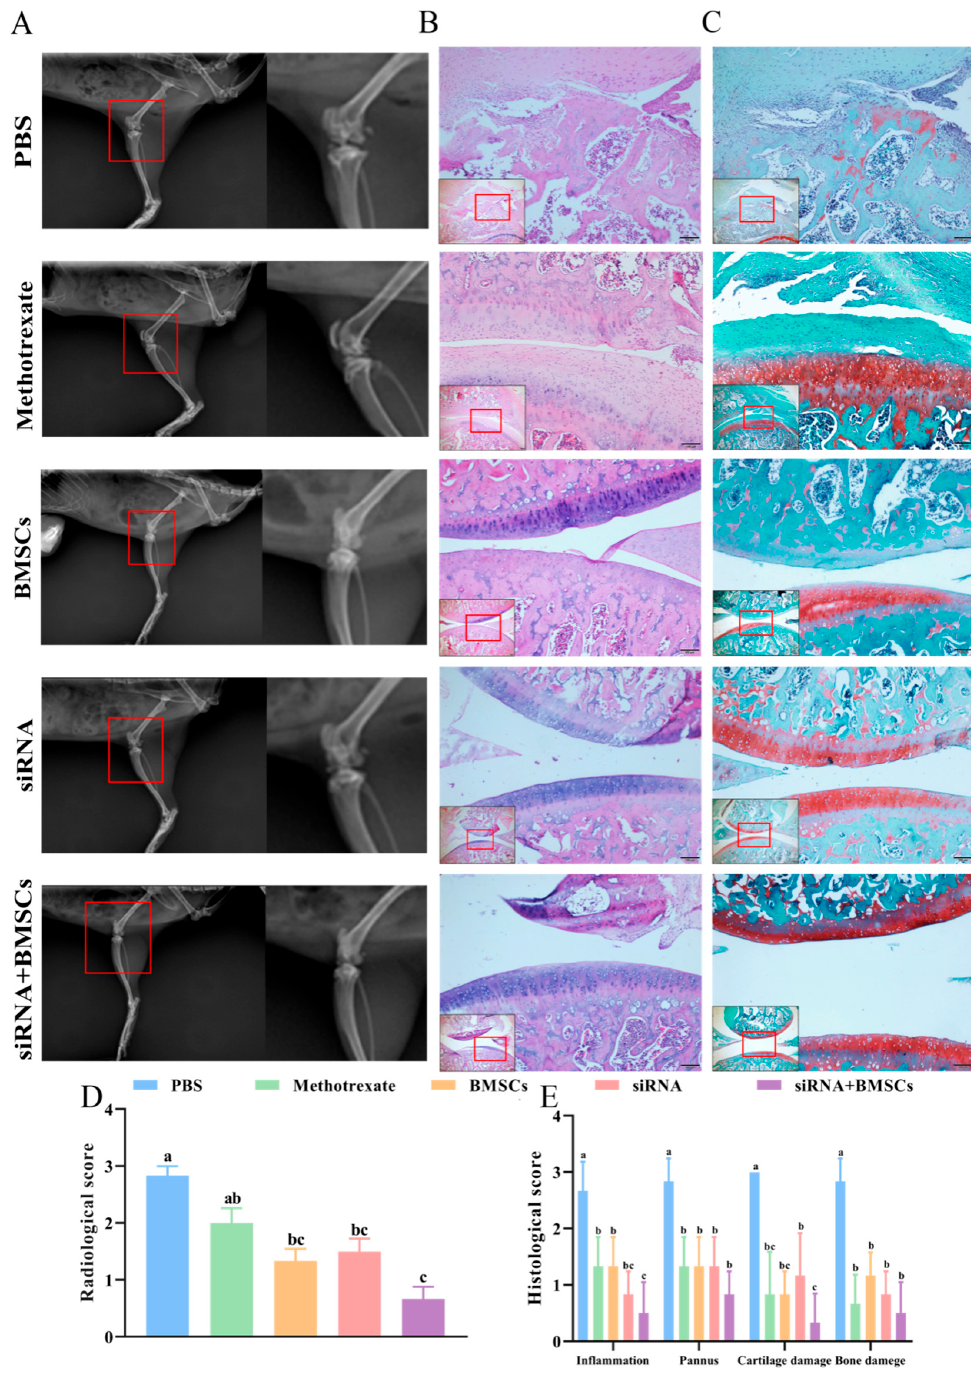
Figure 3. Histopathology of knee joint in CIA rats after 28 days treatment. ( A ), DR-X imaging of knee joint of CIA rats. ( B ), HE staining results of pathological slices of knee joint of CIA rats. (200 µ m, 100 µ m). ( C ), Safranin-O-green staining results of pathological slices of knee joint of CIA rats (200 µ m, 100 µ m). ( D , E ), The radiological and histological scores were evaluated and analyzed, respectively. Values are presented as the mean ± SD, n = 3/group. Different letters mean significant difference among different groups ( p < 0.05).